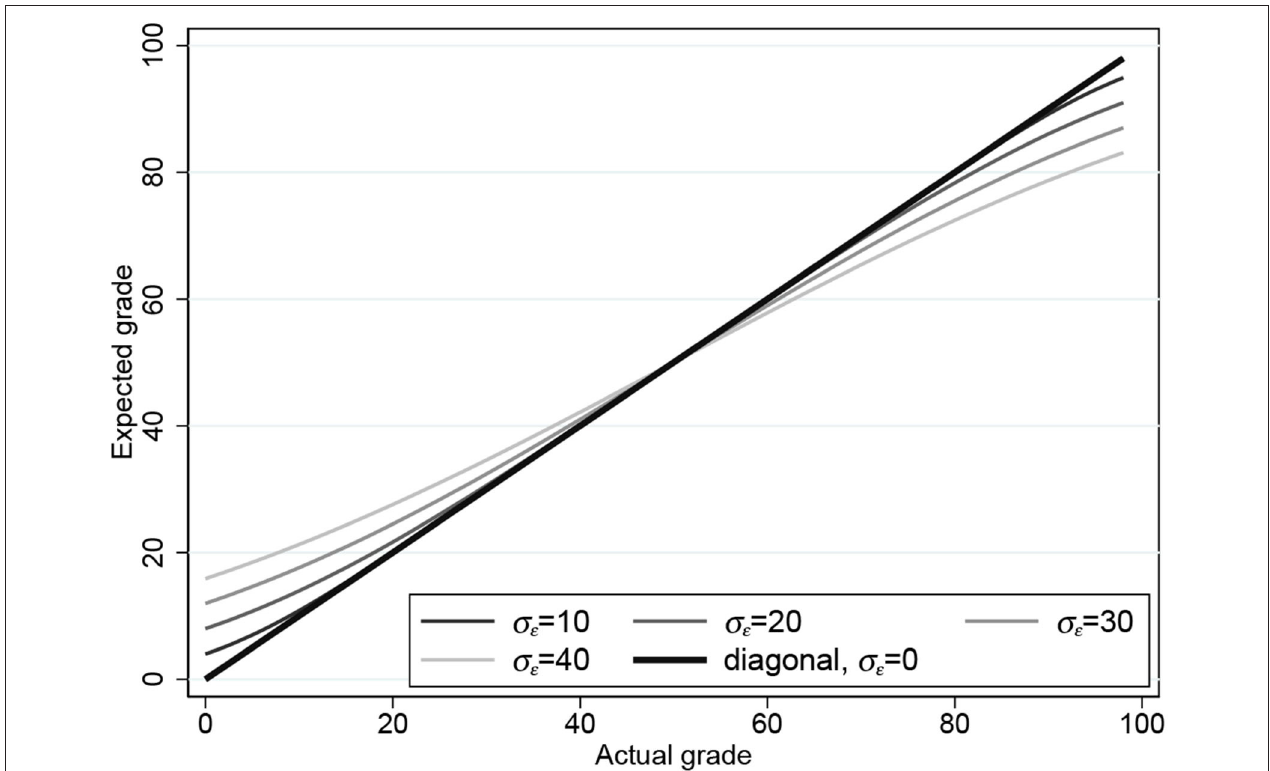
FIGURE 2 | Expectation functions for the one-parameter censored tobit model for σ ǫ = 0,10,20,30,40.